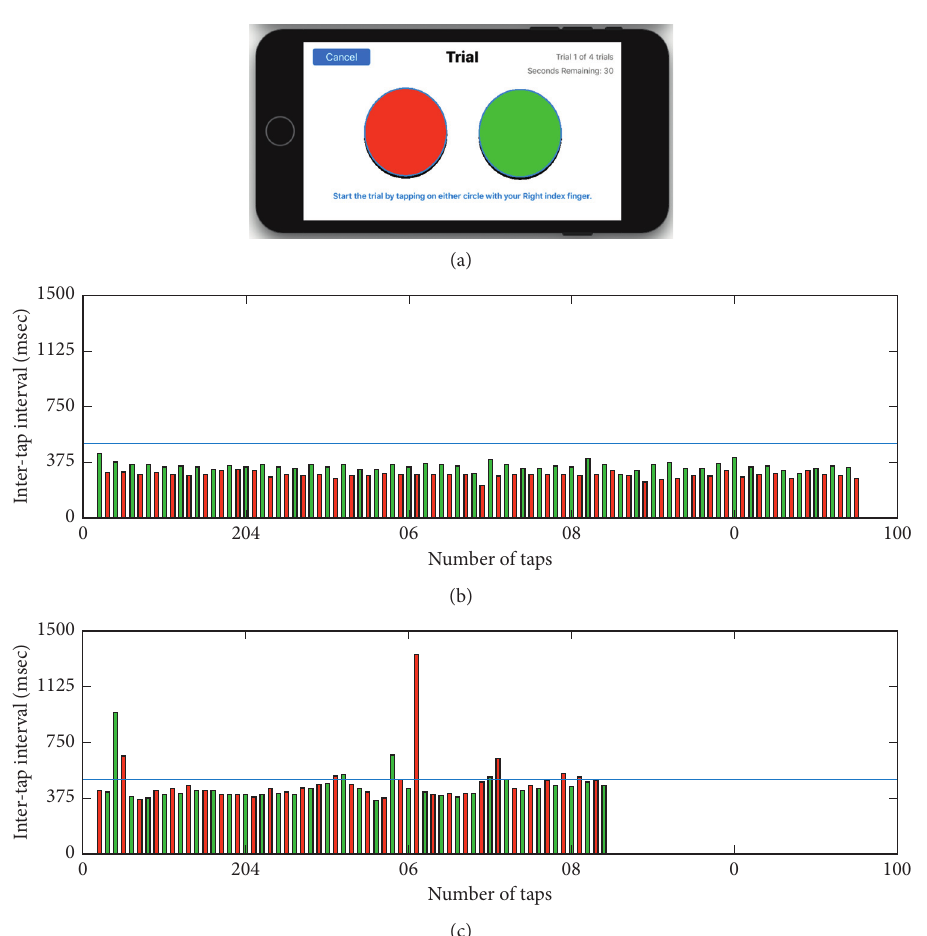
Figure 1: (a) Screenshot of the display from the FTTapplication on an iPhone. Representative data from one participant performing FTT test with their less affected (b) and more affected (c) hands. Each bar represents the time duration (ms) between the onset of consecutive taps (intertap interval) with the left target shown in red and the right one in green. Errors were defined as consecutive taps on the same target. Intertap intervals greater than 500msec were classified as a freeze (blue line denotes threshold for a freeze). The more affected side performed a lower number of total taps compared to the less affected hand (95 vs. 64 taps, resp.), with a longer average intertap interval (461.6 vs. 315.1ms, resp.), committed an increased number of errors (1 vs. 0 errors, respectively), and exhibited a greater number of freezing episodes (11 vs. 0, resp.). Table 2: Summary statistics for virtual MDS-UPDRS III ratings and performance on the digital neurological vital signs. Total